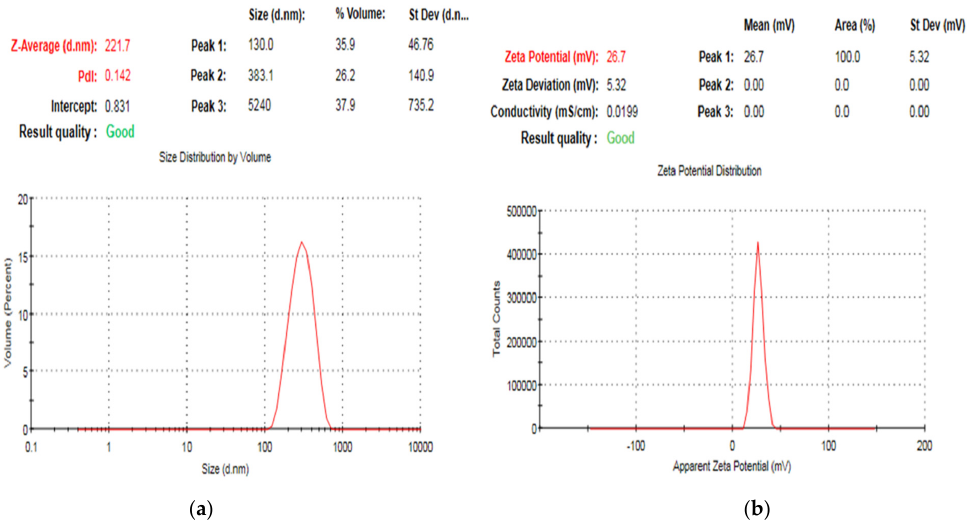
Figure 4. Representative photos showed measurements of ( a ): Particle size and PDI, ( b ): ζ -potential values displaying good quality results.